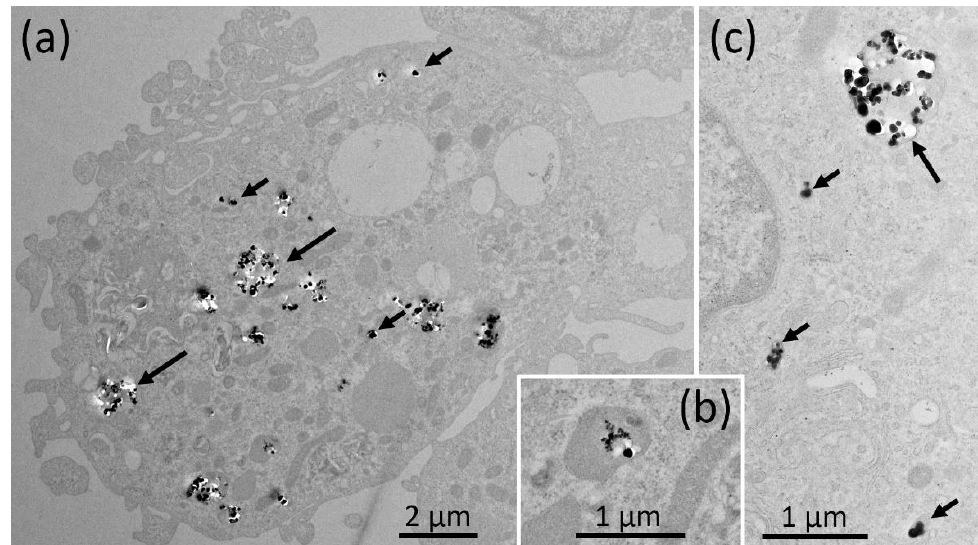
Figure 5. Electron microscopy of NR8383 cells laden with AEROSIL ® OX50 F in the absence of FCS for 16 h. Electron lucent areas close to particles are interpreted as cutting artefacts. ( a ) Overview of a cells with particle-containing phagosomes (large arrows) and smaller endosomes (small arrows). ( b ) shows a typical particle-laden; ( c ) shows a higher magnification of a phagosome (large arrow) and three small endosomes (small arrows) and arrows point to membrane continuities.